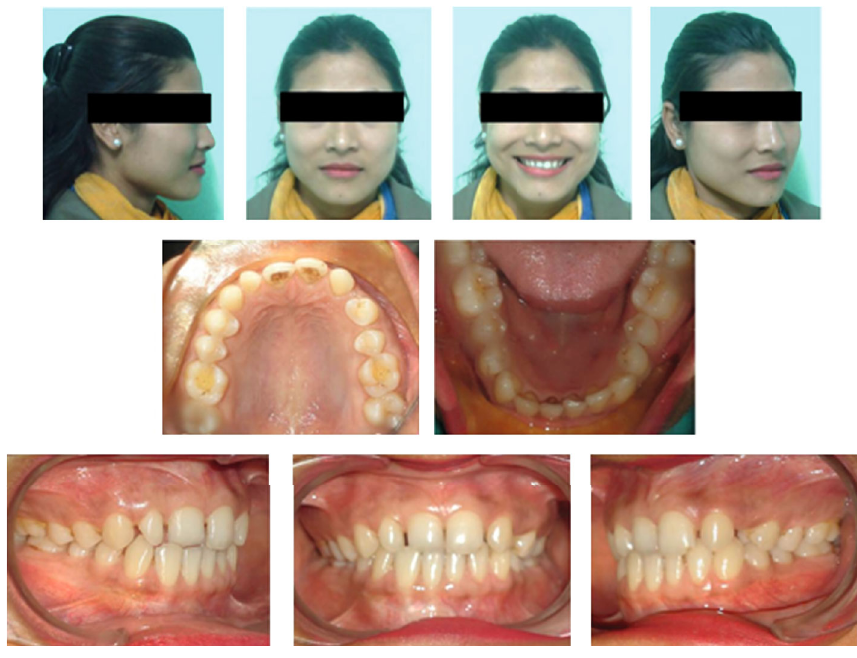
Figure 1: Pretreatment intraoral and extraoral photographs.